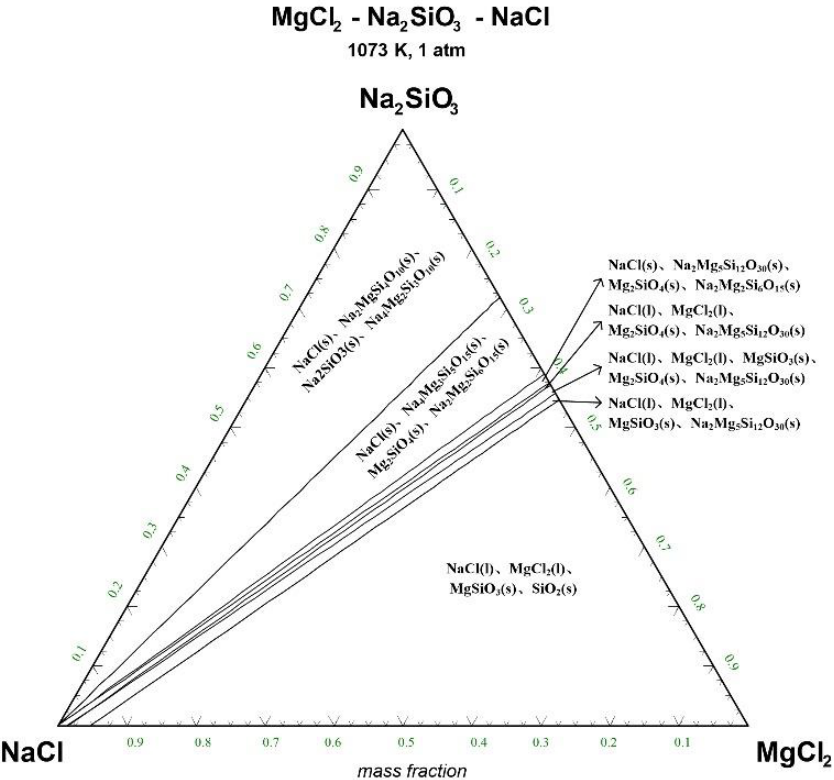
Figure 4. Ternary phase diagram of MgCl 2 -Na 2 SiO 3 -NaCl system at 1073 K. (l — liquid; s — solid).